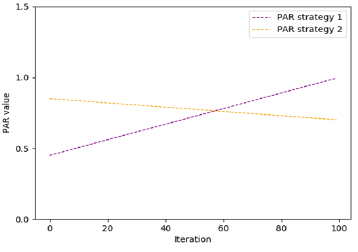
Fig. 6. Change in PAR with